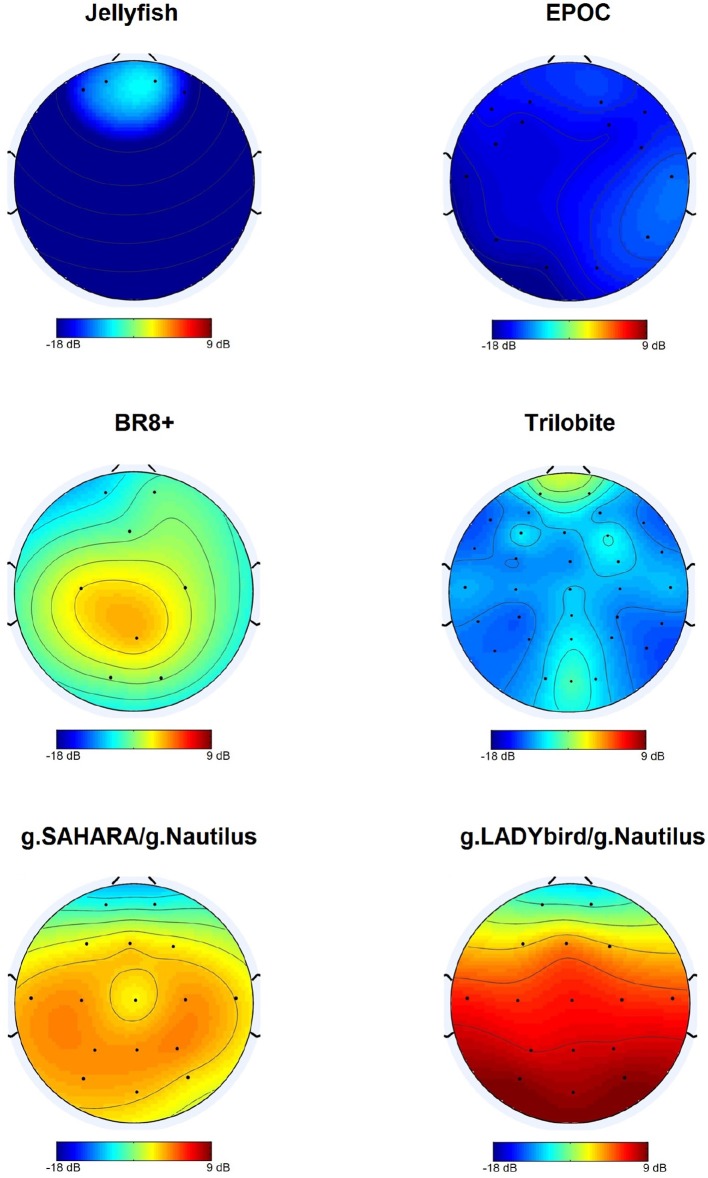
Median SNR values obtained over subjects for each channel.